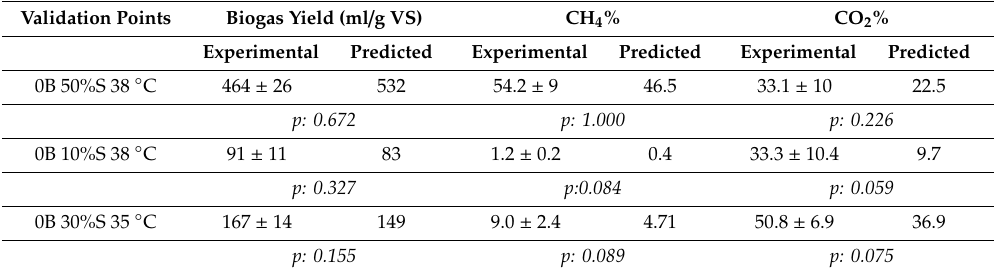
Table 17. Validation experiment results versus predicted results for AD of pot ale.